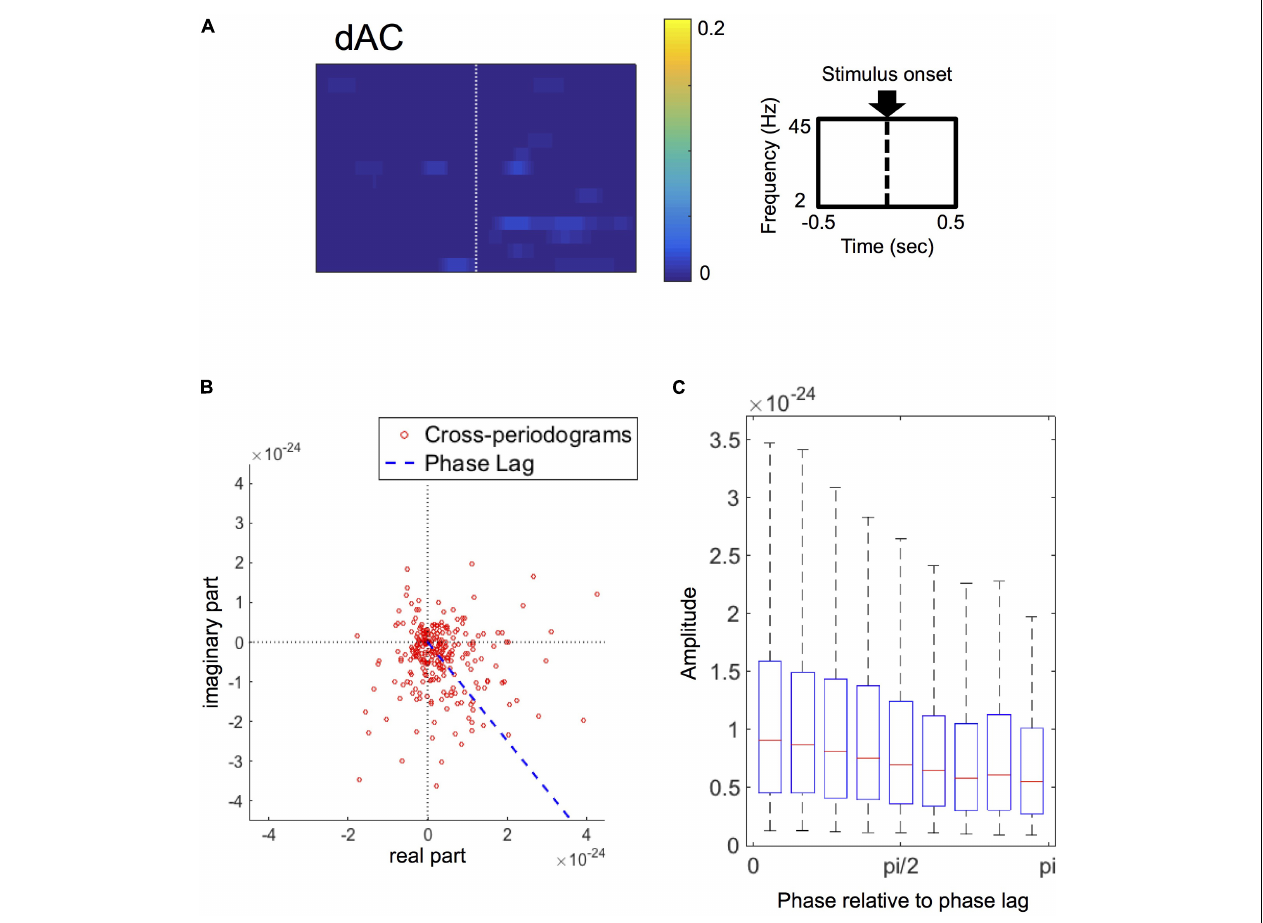
FIGURE 5 | (A) Grand-average of double-thresholded amplitude coherences (dACs) in the time range (abscissa) of 0.5 s before to 0.5 s after the stimulus onset (0 s) and in the frequency range (ordinate) between 2 Hz and 45 Hz. Note that each pixel value represents a proportion of the corresponding pixel to be in significant clusters among all 250 sets of random sampling and all datasets. (B) Polar plot of the cross-periodograms of one representative dataset (dataset 42). Each dot represents each cross-periodogram and the blue dashed line represents the direction of the estimated phase lag. The distribution of the plot appear shifted from the origin toward the direction at the estimated phase lag. (C) Box plots of amplitudes of cross-periodograms sorted into 9 bins according to these phases relative to angles of phase locking (i.e., phase lags). These 9 bins are successive bins from 0 to pi. On each box plot, the red line, the bottom and top edges of the box represent the median, 25th and 75th percentiles of the amplitudes in each bin, respectively. The whiskers represent the 10th and 90th